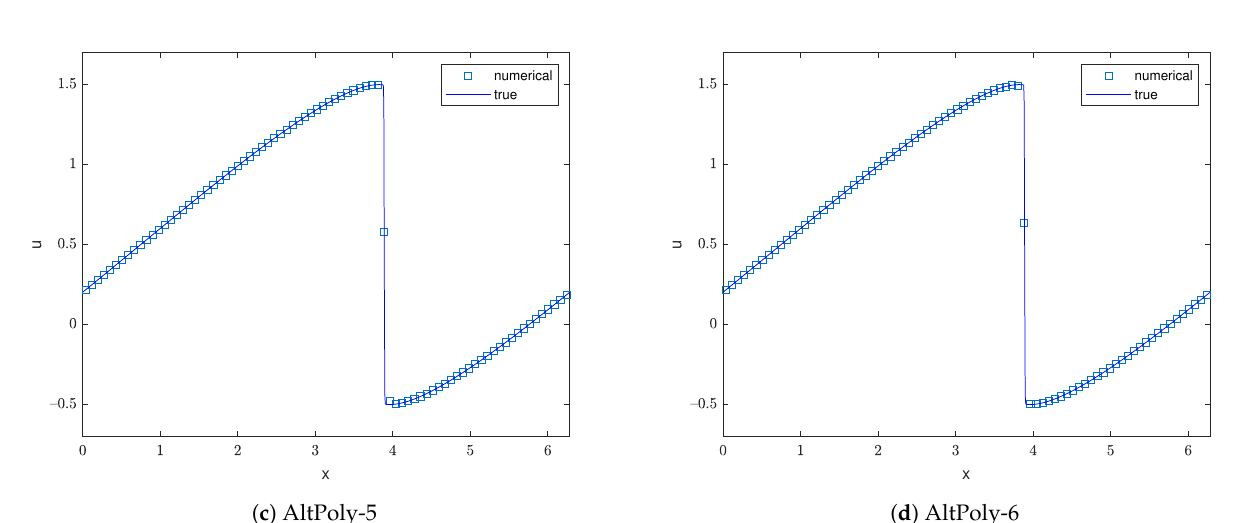
Figure 5. Numerical results of the Burgers equation at t = 1.5 with N = 80 cells and ∆ t = 0.15 ∆ x